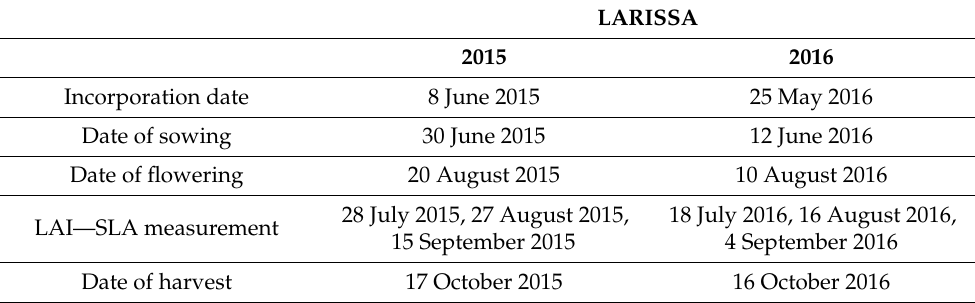
Table 8. Agronomic data of sunflower cultivation.